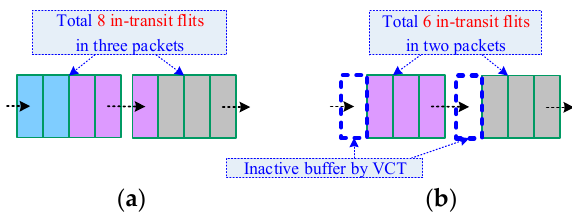
Figure 8. ( a ) Wormhole switching and ( b ) virtual-cut-through switching.